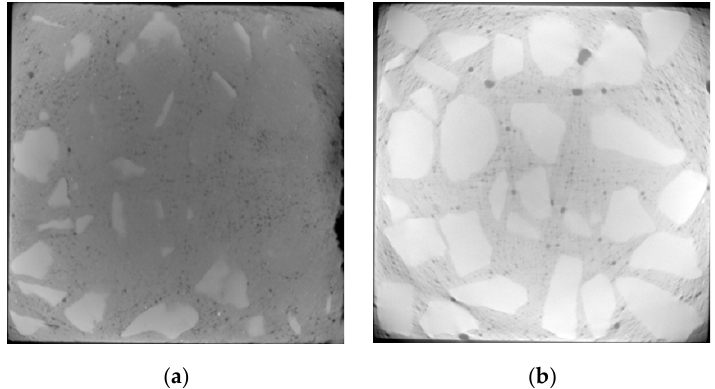
Figure 8. CT images of D4 before sulfate attack (no cracks): ( a ) surface layer; ( b ) inner layer.